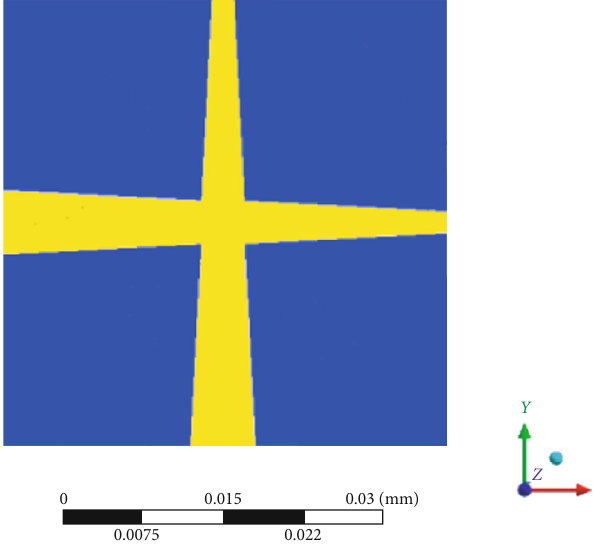
Figure 10: The cross-section of a model introducing fractures with various